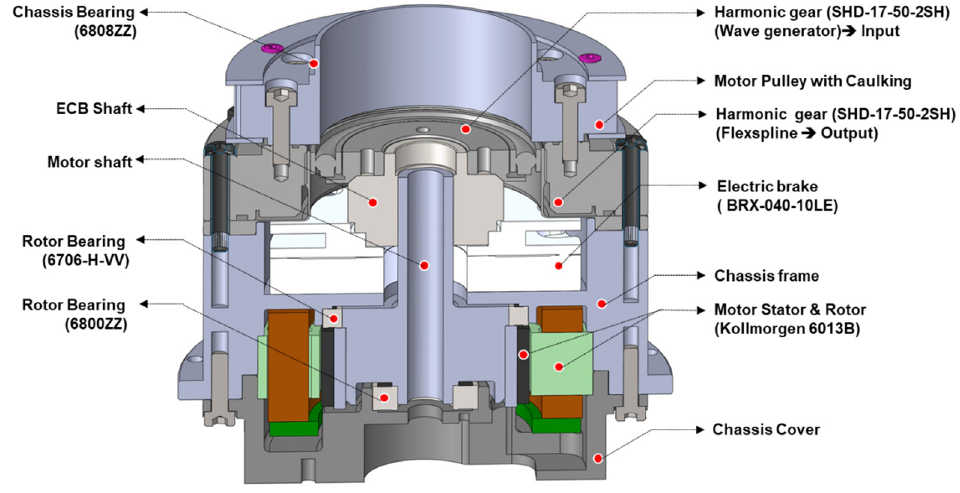
Figure 5. Cross-sectional view of the active drive